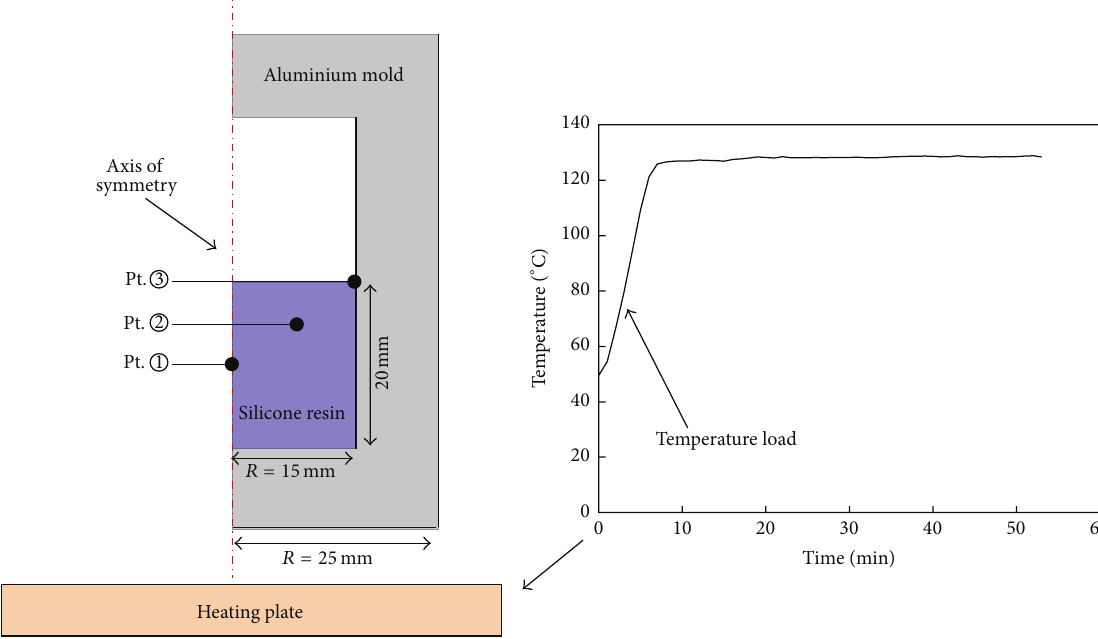
Figure 4: Experimental setup for silicone